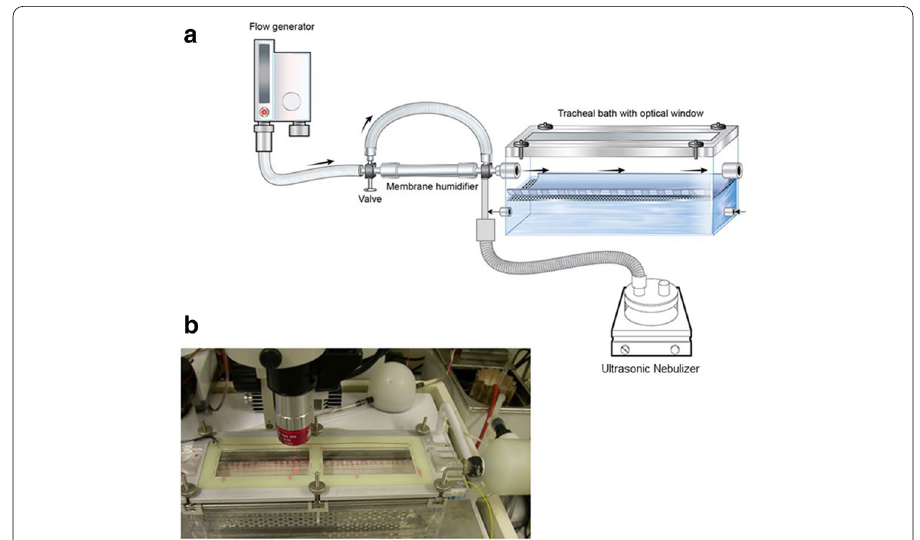
Fig. 1 a Diagram of the experimental setup used for in vitro measurements of mucociliary transport on the tracheal epithelium of perfused lamb trachea. Air-flow was set to 25 L/min and was directed from left to right while mucociliary transport was from right to left. The ultrasonic nebulizer was introduced to the air path before the organ bath. Video-microscopy recordings were made through the heated optical window on the top of the tracheal bath to measure mucociliary transport along the tracheal epithelial surface. b Photo of the in vitro experiment setup with the trachea mounted in the organ bath, with circulation of Krebs–Henseleit solution below. The microscope with coaxial illumination is shown